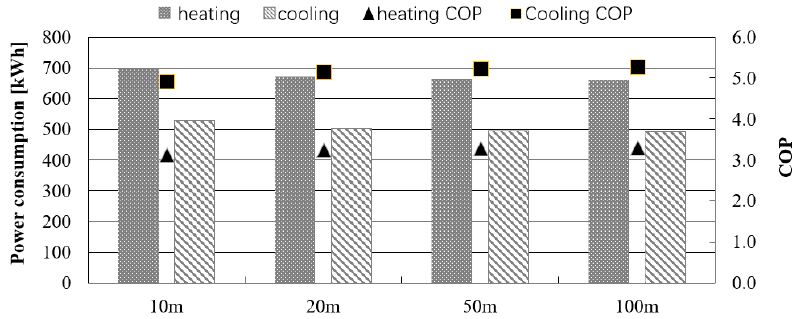
Figure 13. P Electric power consumption and average COPs for different length of GHE. (Effective thermal conductivity 1.0 W/m.K).